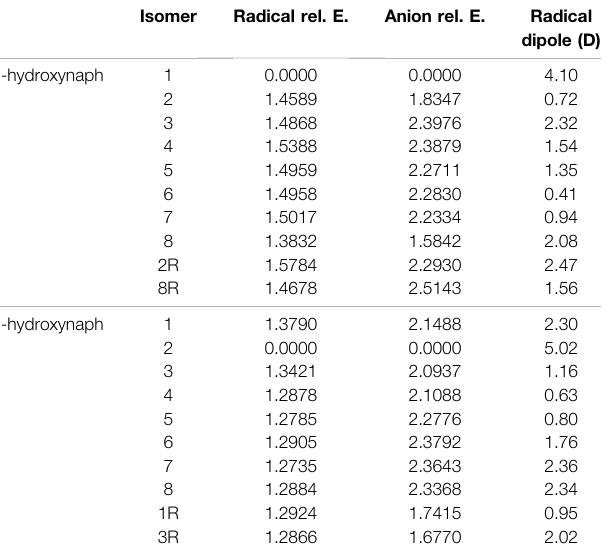
TABLE 3 | The relative energies and neutral radical dipole moments of hydroxynaphthalene derivatives. Isomer Radical rel. E. Anion rel. E. Radical